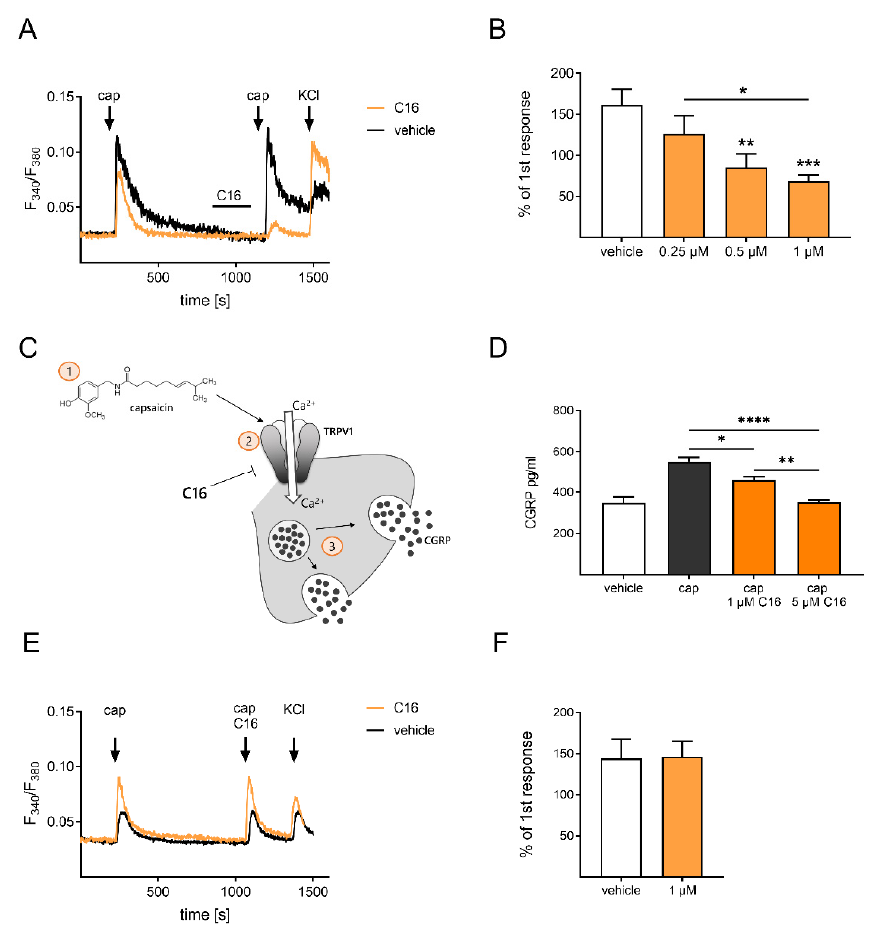
Figure 4. C16 dihydroceramide causes a desensitization of the TRPV1 channel and subsequently leads to a reduced CGRP release from primary sensory neurons. ( A ) Representative calcium responses of sensory neurons, which were pre-treated with C16 for 2 min, followed by an activation of the TRPV1 channel with the agonist capsaicin (100 nM, 30 s). Afterwards, the cells were treated with potassium chloride (50 mM, 45s) to discriminate reacting cells as neurons. ( B ) Quantification of the two calcium responses in ( A ) after capsaicin stimulation (untreated and C16 treated). ( C ) The schematic illustration displays the downstream signaling of TRPV1 after capsaicin activation, which results in the release of CGRP from sensory neurons. A scheme depicting the mechanism was designed using images from motifolio. ( D ) CGRP amount measured in the supernatant of C16 and capsaicin treated sensory neurons. ( E ) Representative calcium responses of sensory neurons, which were treated with both capsaicin (100 nM, 45 s) and C16 (1 µ M, 45 s) at the same time point. ( F ) Quantification of the double stimulation from ( E ), ruling out antagonist properties of C16. ( B , D ) Each condition displays the mean ± SEM of 23–38 measured primary sensory neurons. * p < 0.05, ** p < 0.01, and *** p < 0.001, and **** p < 0.0001, as per one-way ANOVA with a Tukey’s post-hoc test. Abbreviations: CGRP: calcitonin gene-related peptide; cap: capsaicin; KCl: potassium chloride; TRPV1: transient receptor potential cation channel subfamily V member